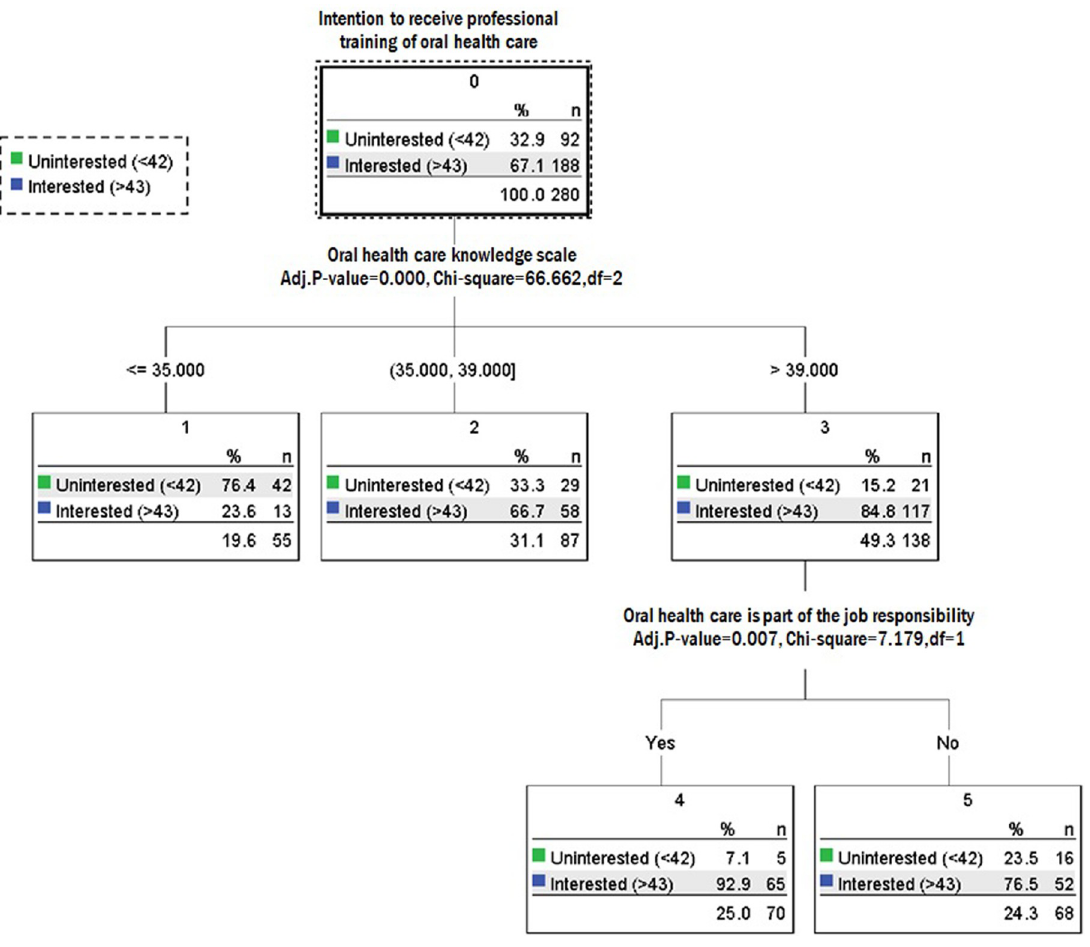
Fig 1. Tree created by the CHAID